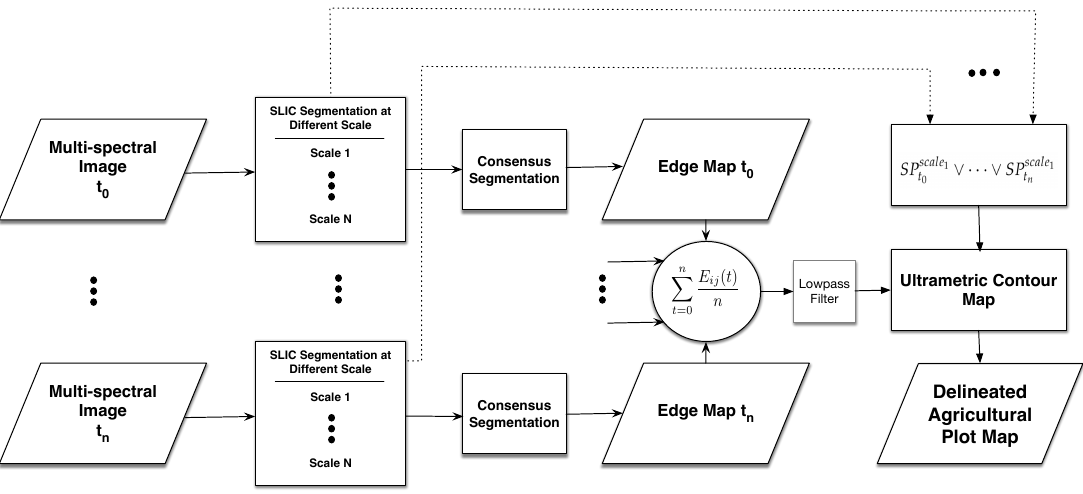
Figure 3. Overview of the methodology